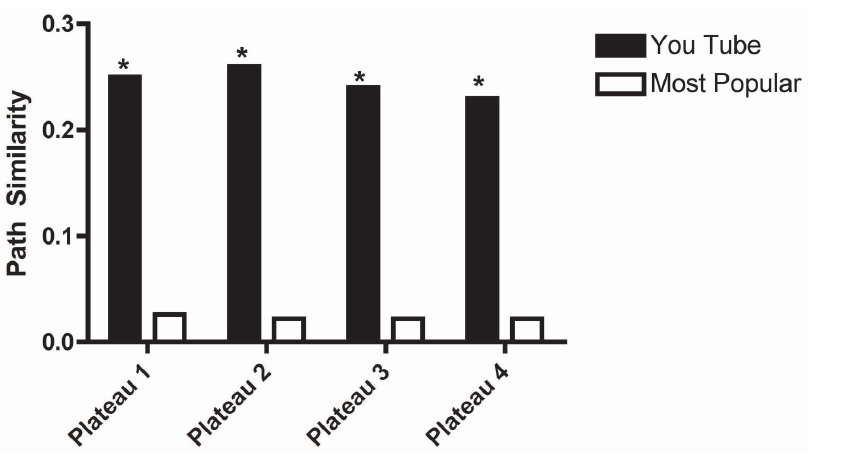
Figure 6. Semantic similarity of YouTube comments to established signs and symptoms of dextromethorphan use. The black bars refer to ‘‘Robo-tripping’’ videos from YouTube, the white bars to the most popular videos (see sec:Methods). All values for path similarity are calculated relative to the signs and symptoms mentioned in [25].